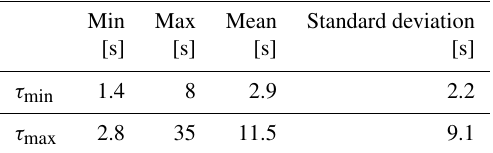
Table 3. Typical values of τ min and τ max that are used during LATTE for the OU